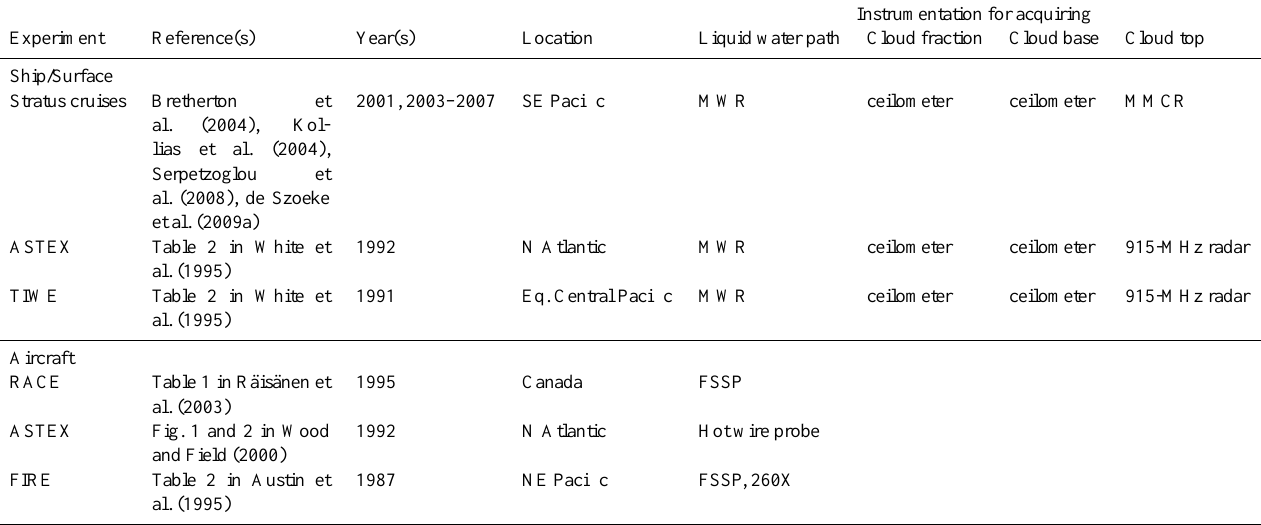
Table 1. In situ data used in this study. See the text for the meaning of the experiment